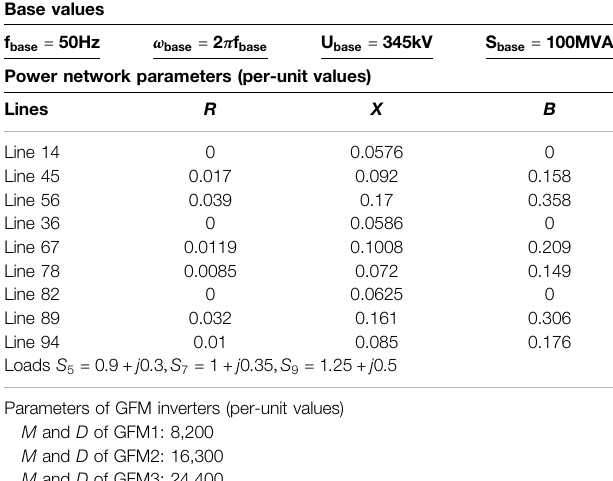
Parameters of GFM inverters (per-unit values) M and D of GFM1: 8,200 M and D of GFM2: 16,300 M and D of GFM3: